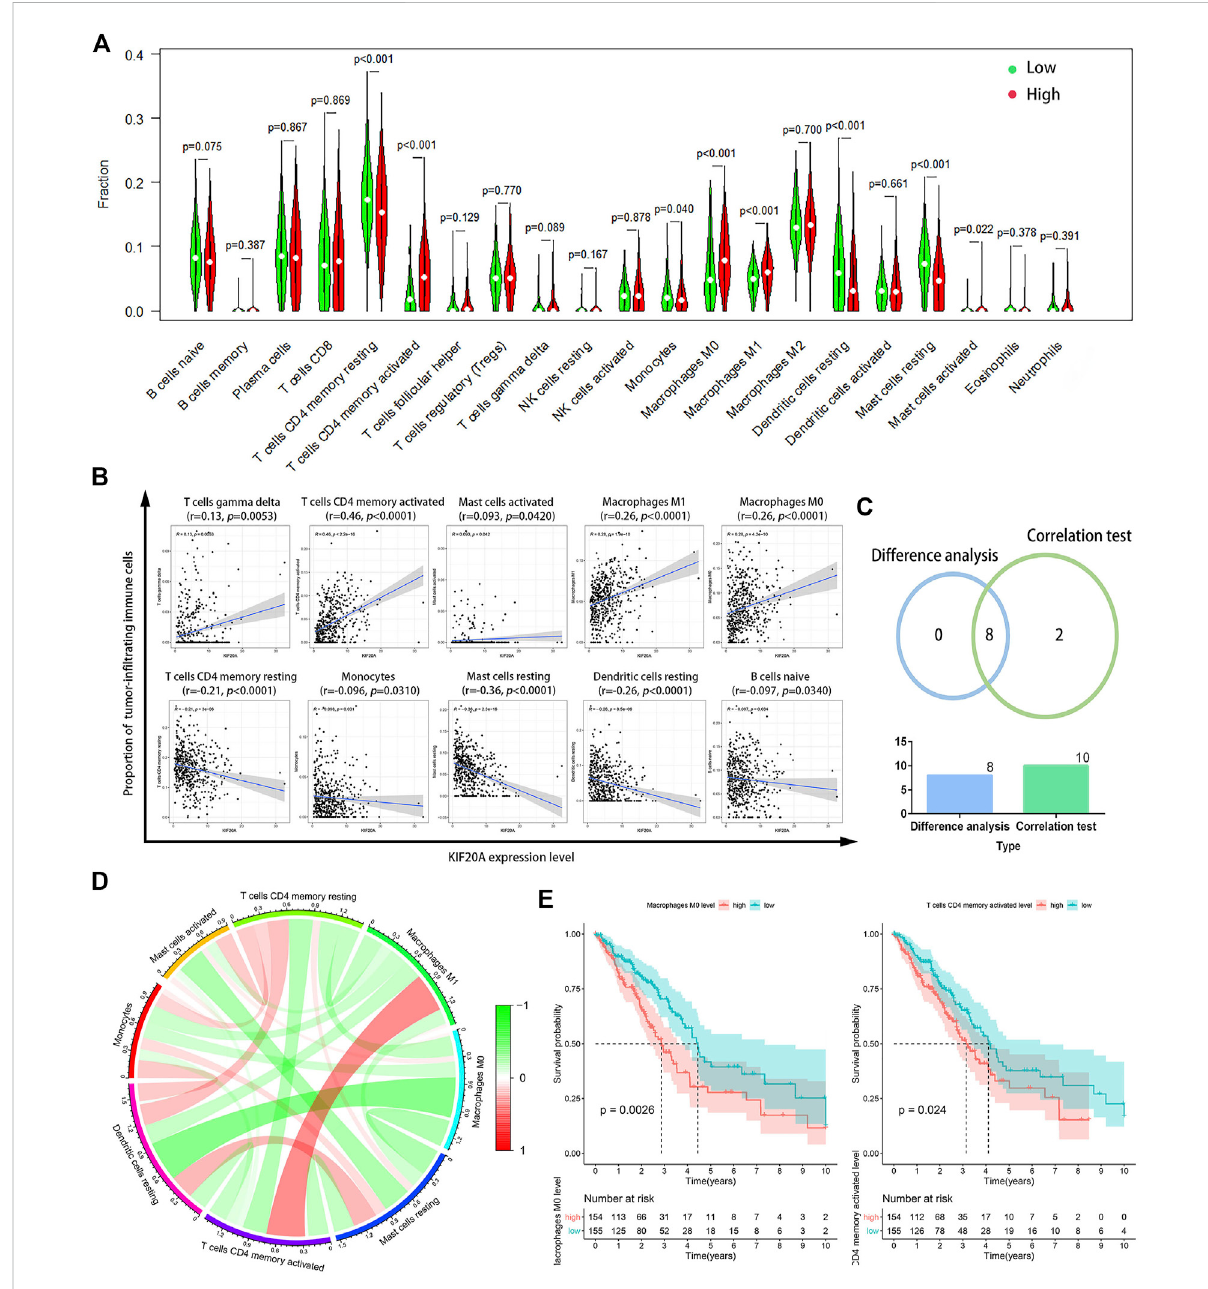
FIGURE 9 Correlation of KIF20A expression with tumor-in fi ltrating immune cells (TICs) proportion. Differential analysis (A) for the proportions of 21 kinds of TICs in LUAD samples with low or high KIF20A expression levels relative to the median KIF20A expression level. Scatter plots (B) show the correlation between the levels of the ten kinds of TICs and the KIF20A expression ( p < 0.05). Venn diagram (C) shows the eight kinds of TICs correlated with KIF20A expression overlapped by the differential analysis and correlation test. Circle plot (D) shows the correlation among the eight different types of TICs. Image (E) illustrates the Kaplan-Meier overall survival (OS) analysis for the proportions of two types of TICs ( p <